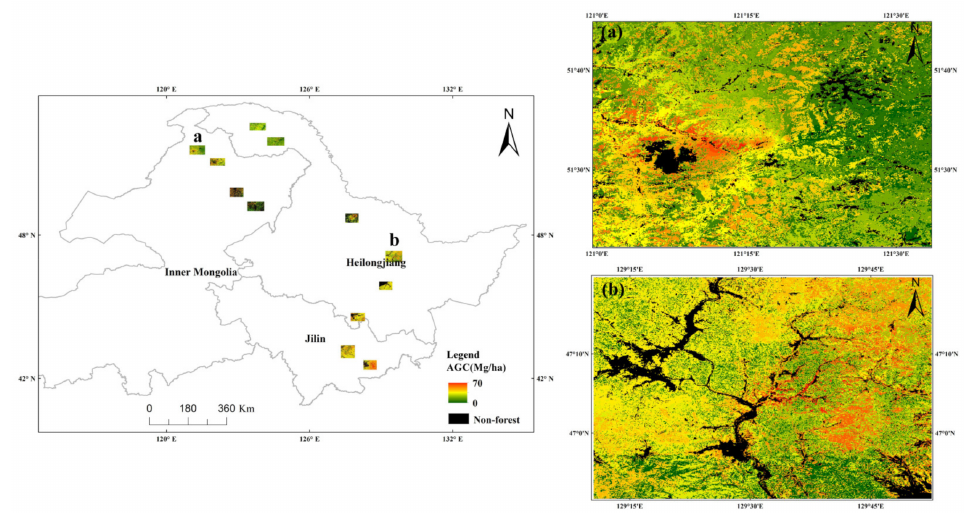
Figure 8. Forest AGC estimation map in the study area retrieved by the CatBoost models based on DSS. ( a , b ) Spatial distribution of estimated forest AGC in two areas at a larger